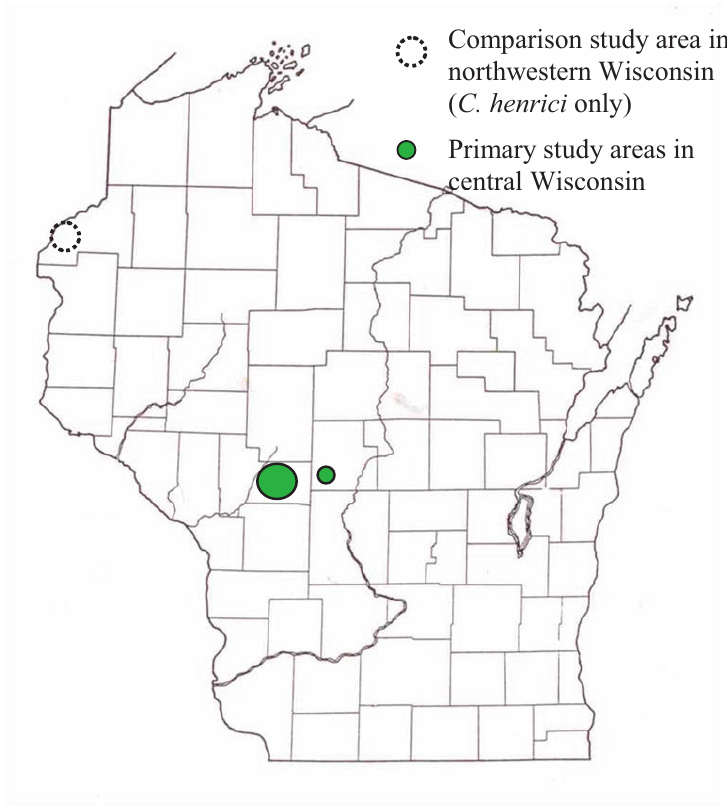
Figure 1. Map showing study regions in central and northwestern Wisconsin.